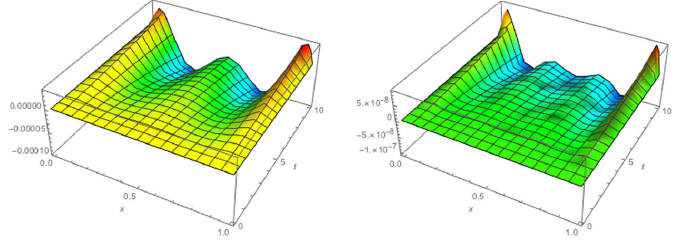
Figure 5. The absolute errors for β = 0 . 5 and γ = 0 . 25 with M = 4 ,N = 6 (left) and M = 6 ,N = 6 (right) on the interval [0 , 1] × [0 , 10] of Example 6.